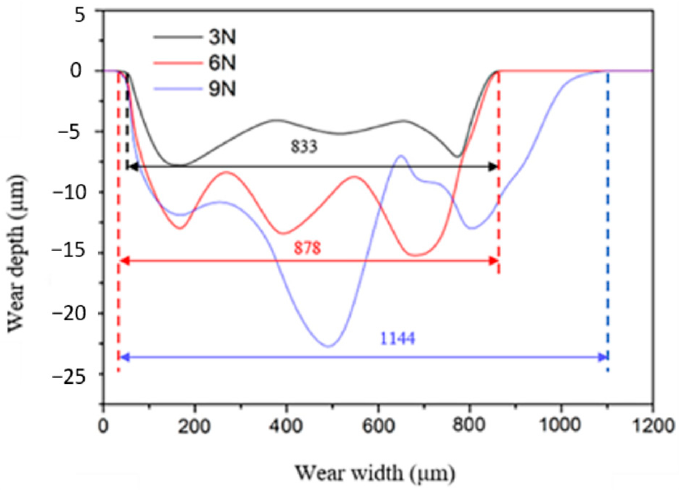
Figure 11. Wear cross-section trajectory curve of alloying coating under different load.